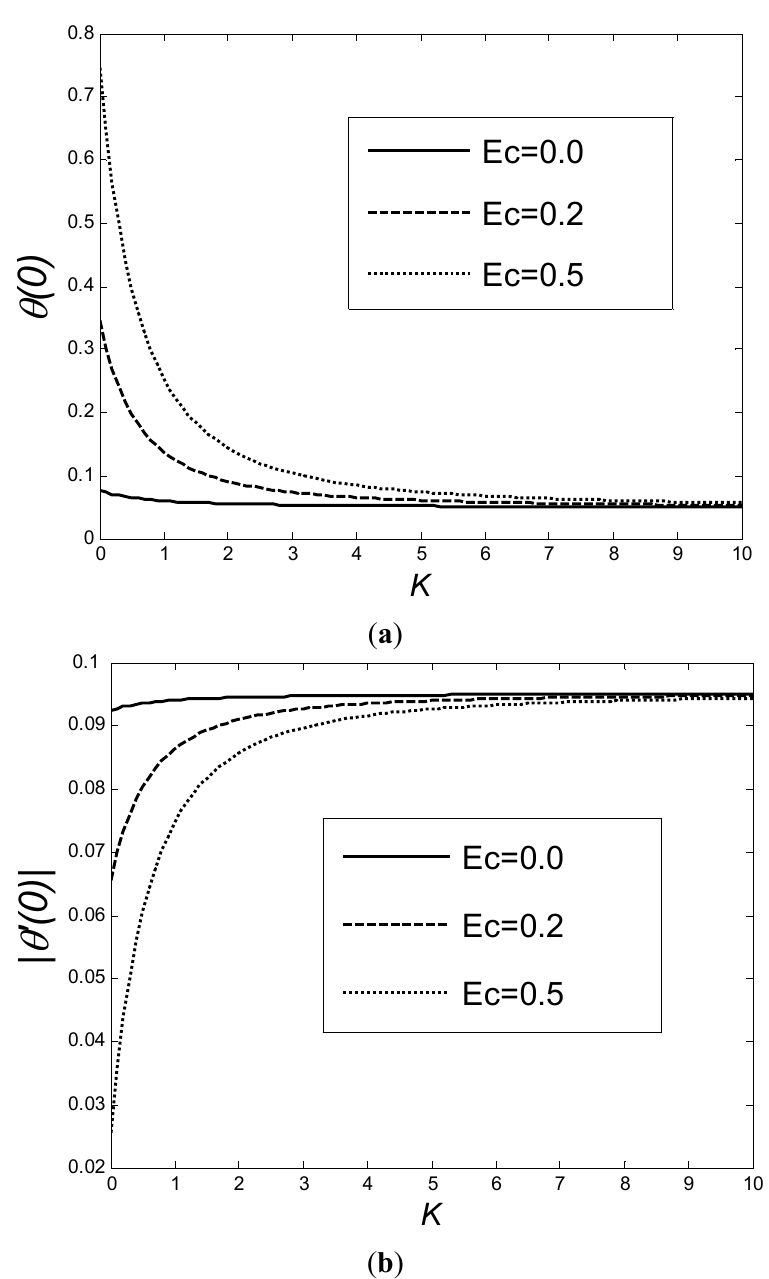
Figure 11. ( a ) Variation of the θ (0) and ( b ) | θ ' (0)| as a function of K for various values of Ec when a = 0.1, f = 0.2, Pr = 7 and M = w